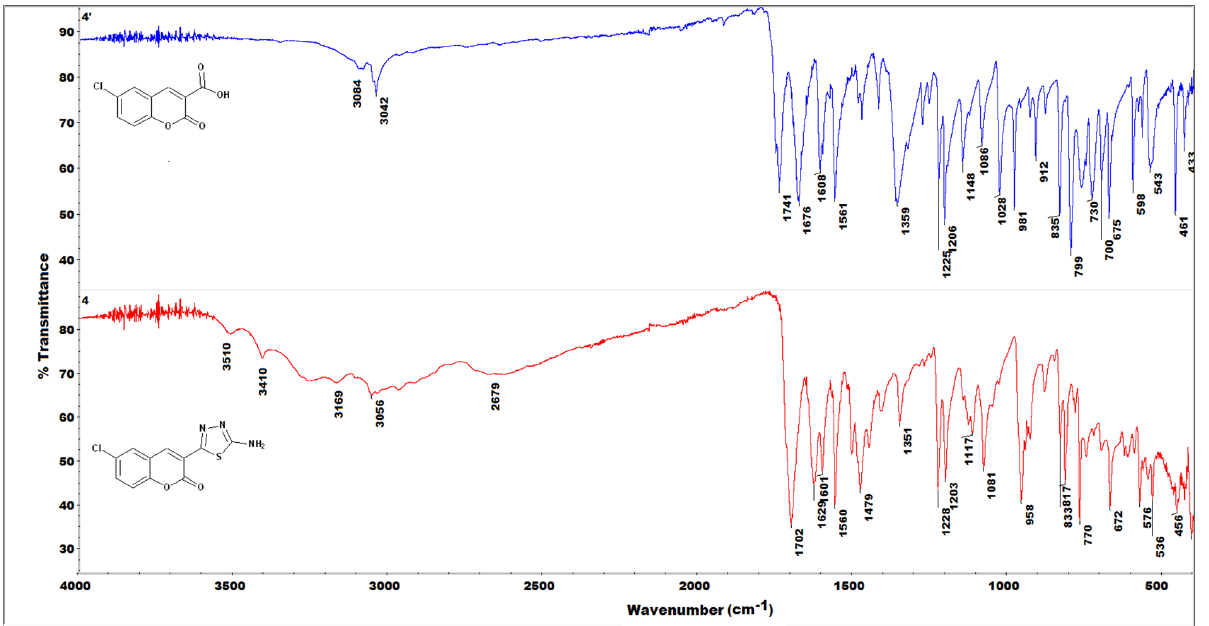
Figure 5. Comparison of the IR(ATR) spectra of coumarin-3-carboxylic acid 4 ′ ( top ) and the corre- sponding coumarin–thiadiazole hybrid 4 ( bottom ). sponding coumarin–thiadiazole hybrid 4 ( bottom